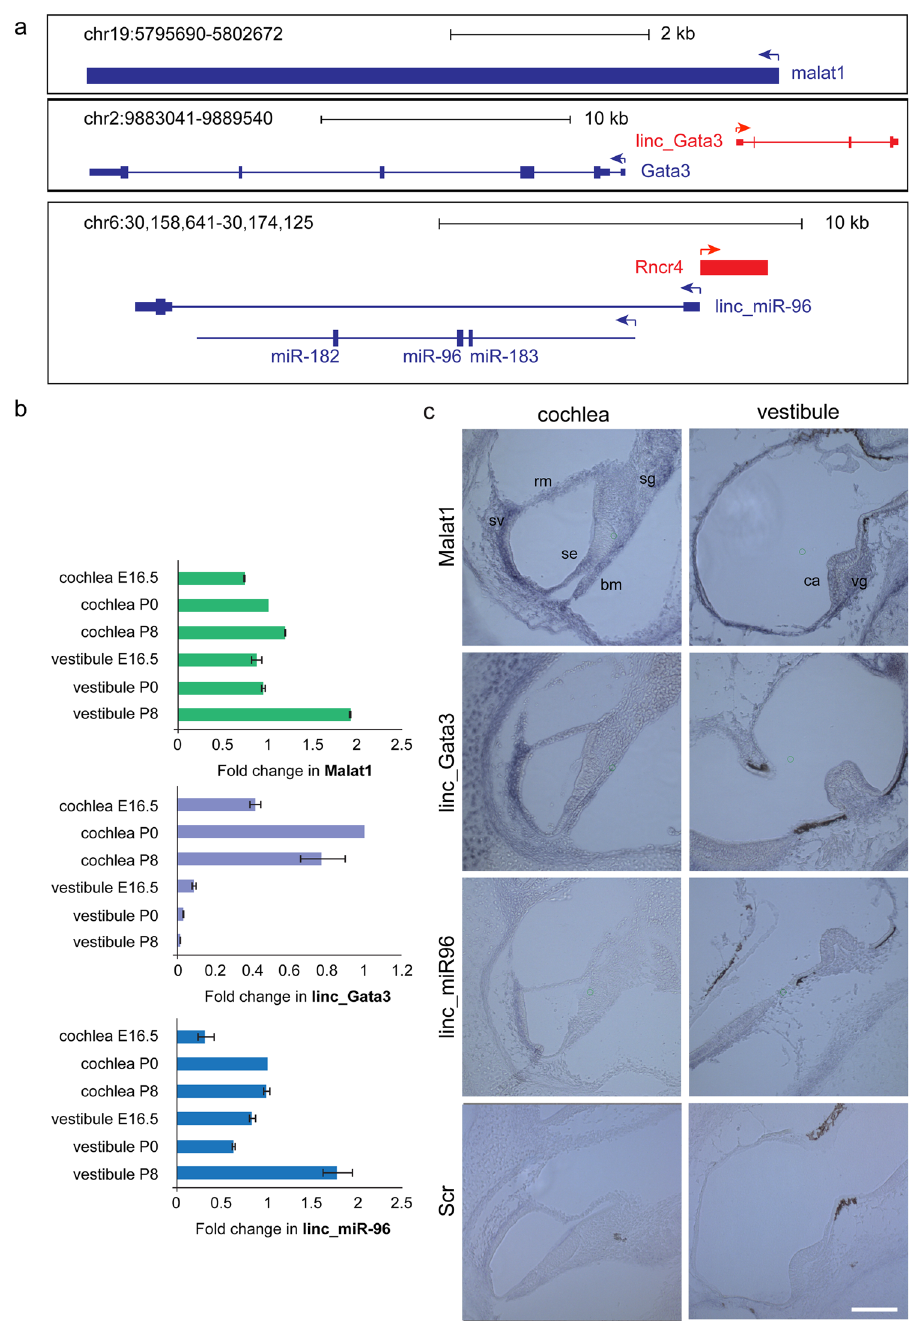
Figure 5. Spatial and temporal expression of lncRNA candidates in the inner ear. ( a ) Graphical representation of the genomic locus of Malat1, linc_Gata3, and linc_miR96. ( b ) Expression of three lncRNA candidates Malat1, linc_Gata3, and linc_miR96 in the developing inner ear, probed at three developmental stages (E16.5, P0, and P8) using qRT-PCR. ( c ) Specific expression patterns for lncRNAs by ISH at P0. Whole-mount inner ears were hybridized with LNA probes, followed by cryosectioning. For each lncRNA, images of the cochlear organ of Corti and vestibular crista ampullaris are shown. The bottom panel shows the scrambled (Scr) control LNA probe. Vestibular dark cells are present in all images of the vestibule, including the negative control. Scale bars: 100 μ m. Abbreviations: se, sensory epithelium; rm, Reissner’s membrane; bm, basilar membrane; sv, stria vascularis; sg, spiral ganglion; ca, crista ampullaris; vg, vestibular